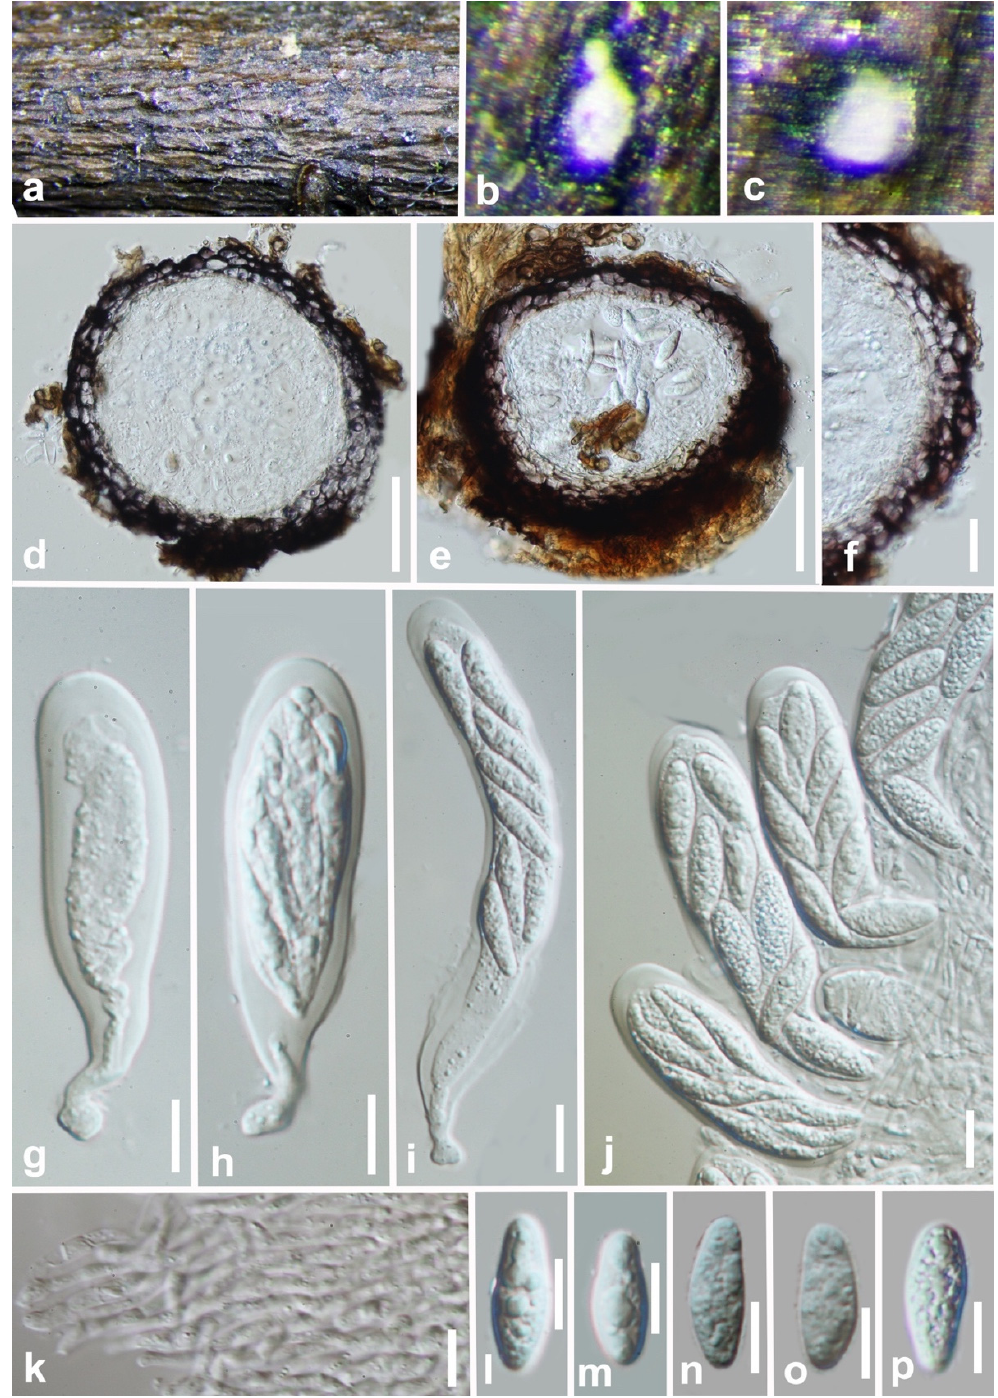
Figure 9. Sphaeropsis guizhouensis (HKAS 112084, holotype). ( a – c ) Appearance of ascomata on wood. ( d , e ) Vertical section of ascomata. ( f ) Peridium. ( g – j ) Immature and mature asci. ( k ) Pseudoparaphyses. ( l – p ) Hyaline mature ascospores. Scale bars: ( d , e ) = 50 µm, ( f ) = 20 µm, ( g – p ) = 10 µm.